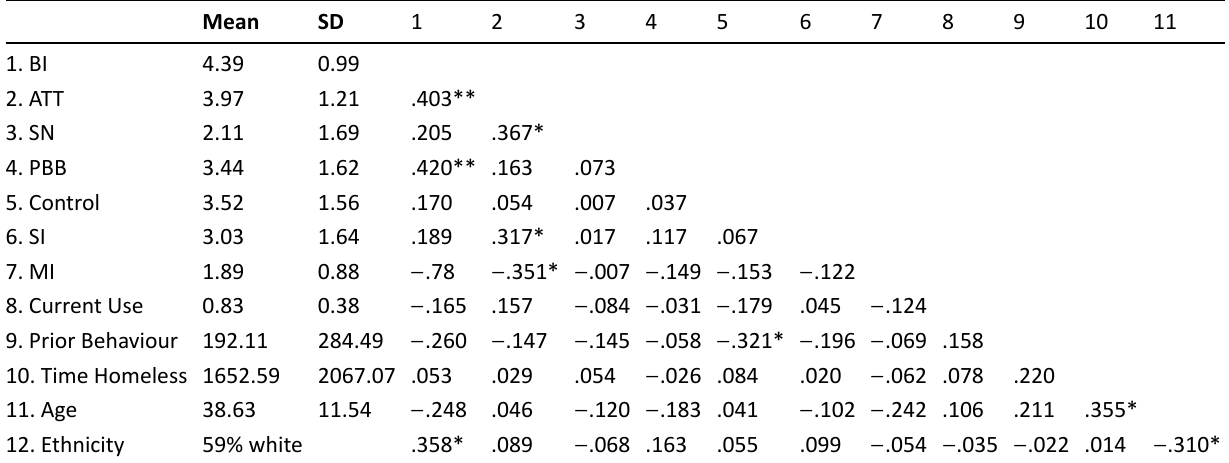
Table 1. Descriptive statistics and intercorrelations ( n =